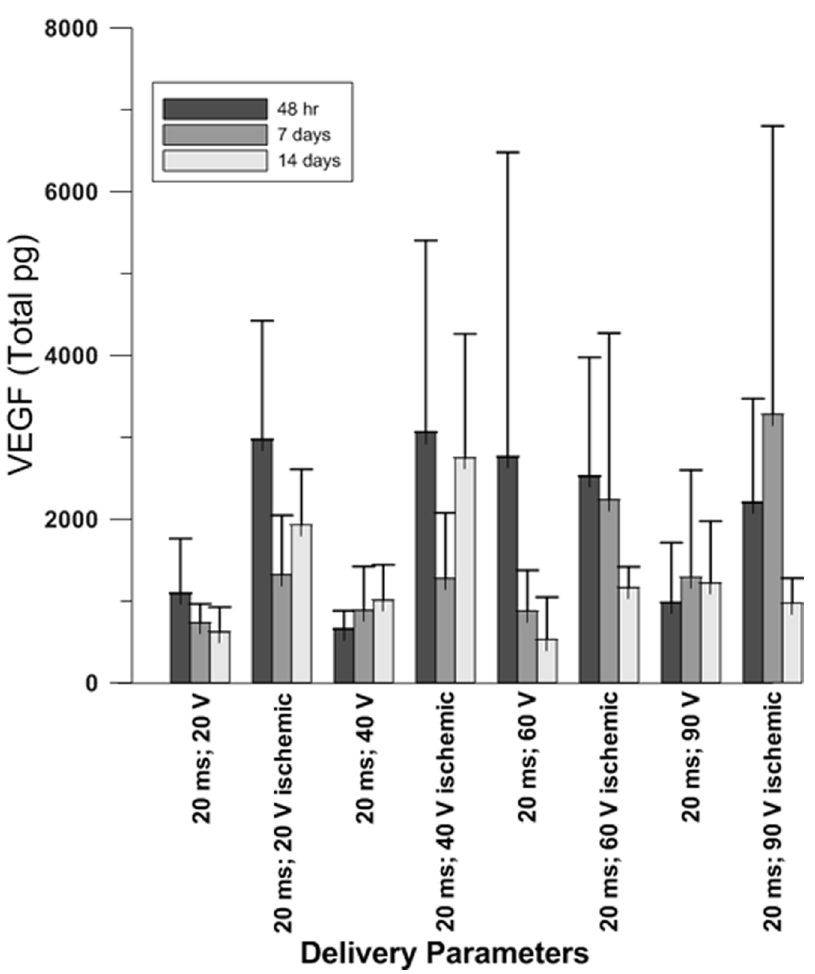
Fig. 3. Expression of pVax1-hVEGF 165 . pVEGF expression was analyzed over a two week period at 48 hours, 7 days and 14 days. Peak expression was observed at 48 hours in all ischemic tissues at all parameters except 20 milliseconds; 60 V. VEGF expression was significantly greater in the 20 milliseconds; 60 V parameter 14 days after ischemia was produced.